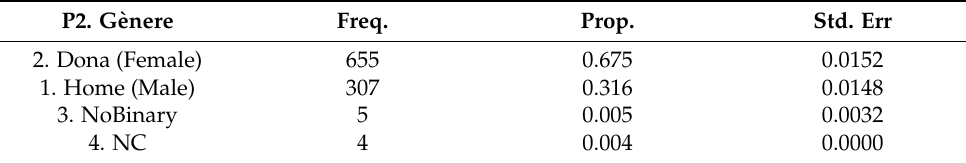
Table 3. Extended Frequency table of